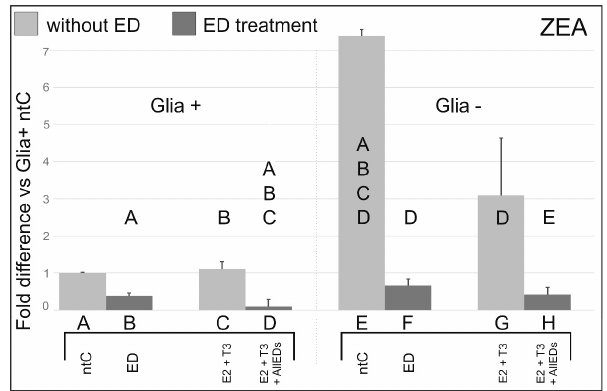
Figure 2. Effects of zearalenone (Zea) with, and without, 17beta-estradiol (E2) and triiodo-thyronine (T3), on ER β mRNA expression. ER β mRNA expression was substantially reduced by Zea treatment compared to the respective ntCs and Zea-void hormone treated cultures. Letters in and above the columns indicate significant differences ( p ď 0.05) from columns